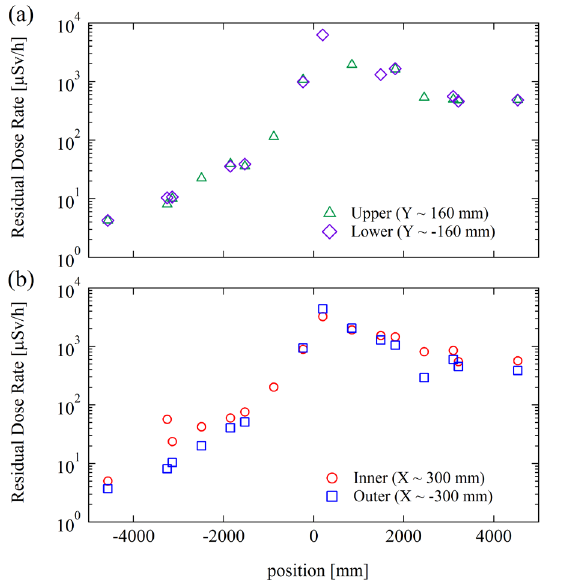
Fig. 4. Typical measurement results of residual dose rate distribution around stripper